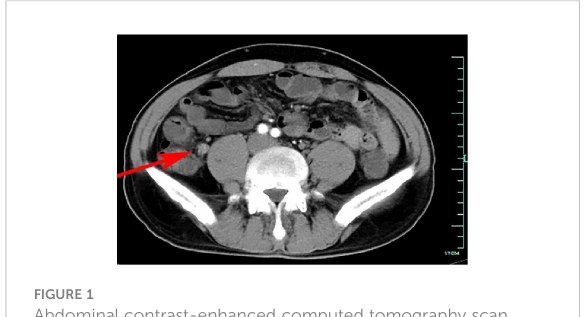
FIGURE 1 Abdominal contrast-enhanced computed tomography scan showing dilated appendix with high density in the lumen.